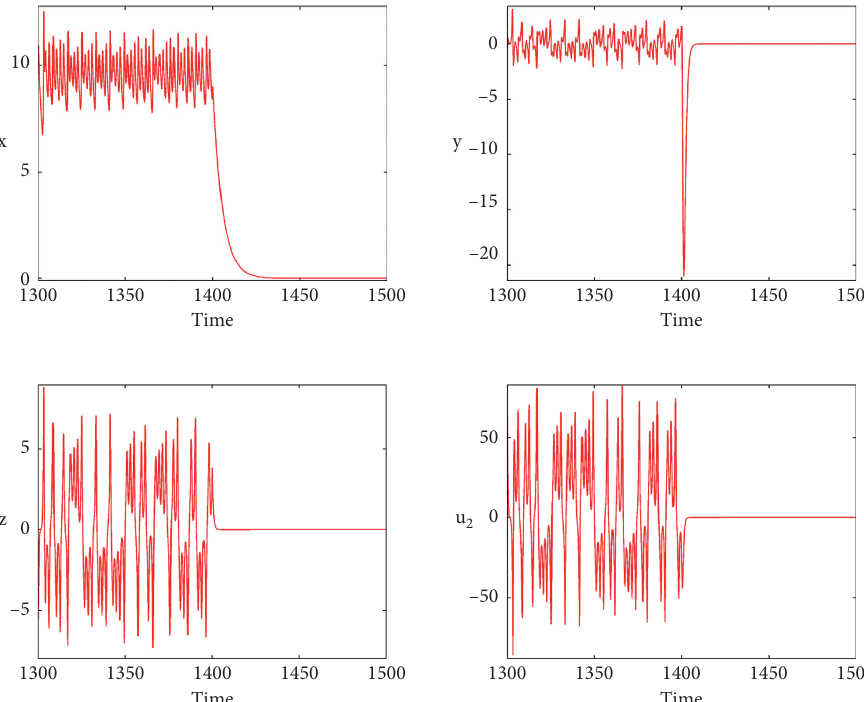
Figure 5: Time series of x,y, z , u for a � 3, b � 0 . 2 and c � 22. The initial conditions are (x(0), y(0), z(0)) � (0.1, 0.2, 2